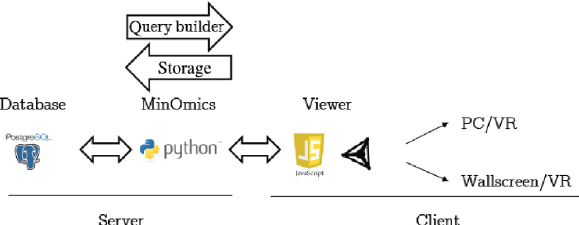
Figure 1: MinOmics web framework. Visual immersion into biological big data requires an efficient database manage- ment strategy. MinOmics assists the storage of massive datasets in PostgreSQL and building queries for an ultra fast ex- ploration of biological data. Javascript and UnityMol-WebGL, a powerful molecular visualization framework, provide full immersion and real-time interactivity to the